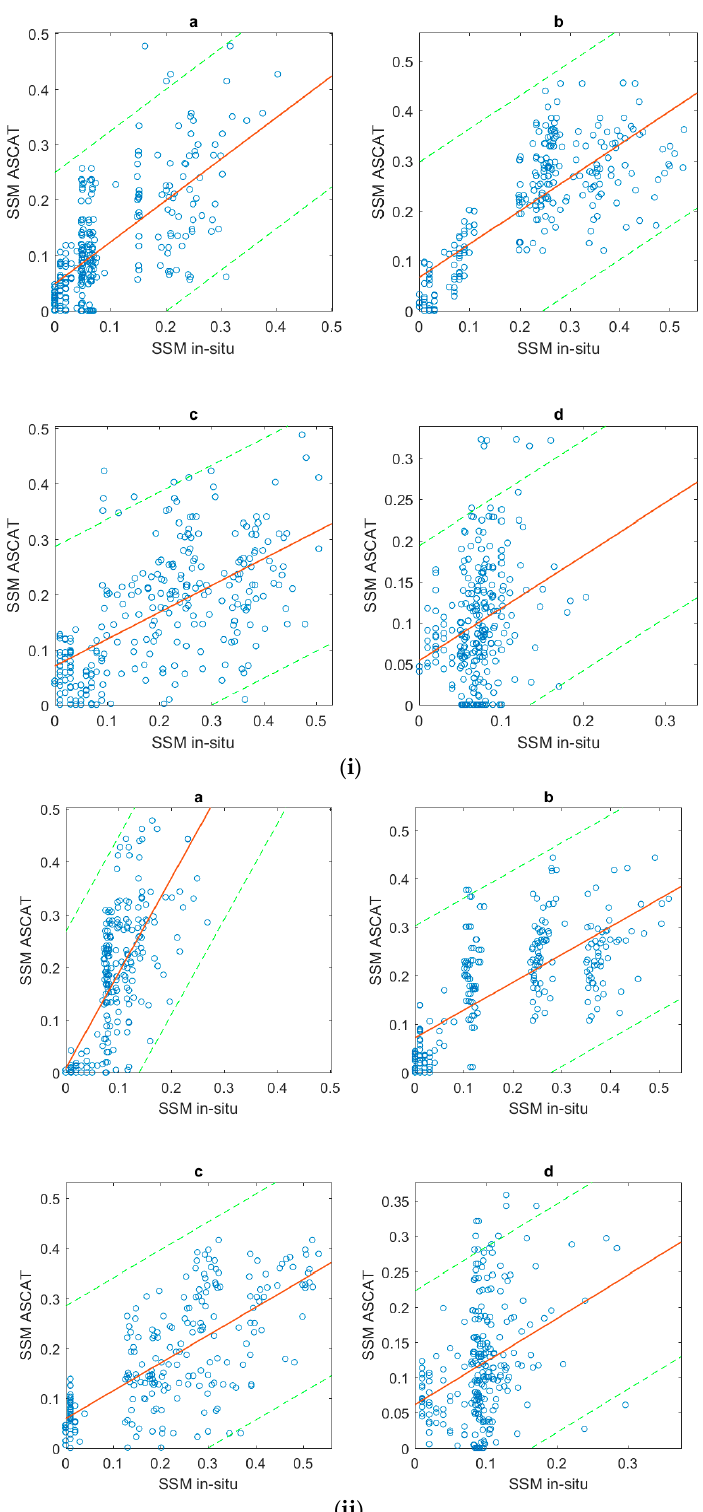
Figure 8. Scatter diagram of in situ and predicted SSM from ASCAT 25Km for the different seasons for all sites in EUROPE together shown here for year ( i ) 2010 and ( ii ) 2011. For all sites in USA ( a ) Autumn, ( b ) Winter, ( c ) Spring, and ( d ) Summer. The green dashed lines represent the 95% confidence level.